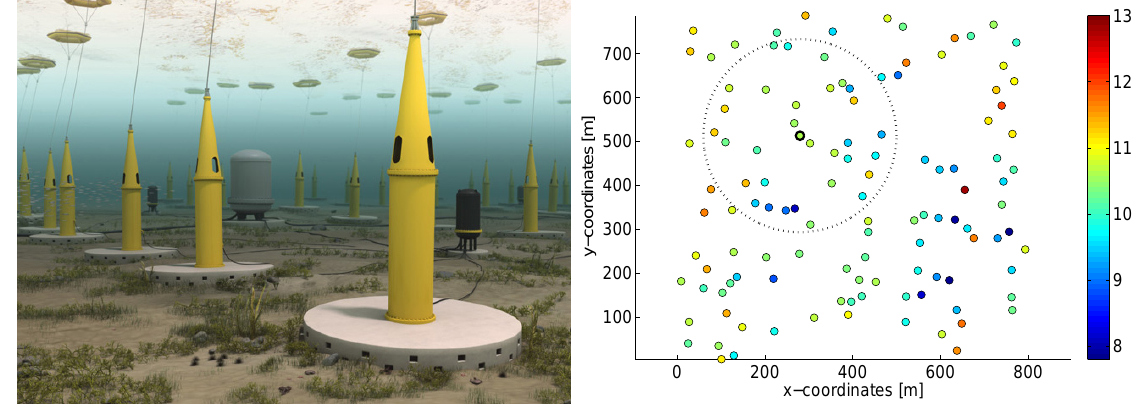
Figure 1. Illustration of a wave energy farm and a simulation of a farm consisting of 120 WECs in a random configuration. The time-averaged power absorption of the individual WECs (kW) is shown with the color bar. The dotted circle illustrates the concept of using interaction distance cut-off in the simulations; in any given array, the hydrodynamical interaction may be computed only between WECs within a specified distance, which speeds up the computations and reduces memory usage, but retains a high accuracy. Table 1. Nomenclature and parameter values, where a numerical value